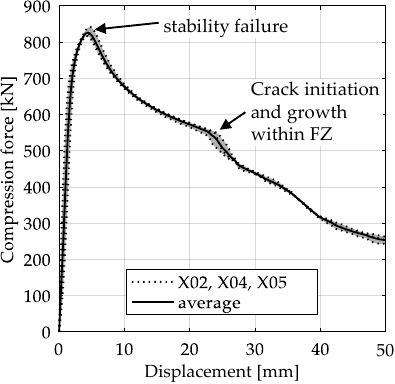
Figure 17. Averaged force–displacement curve with scatter band of axial compression tests with 10-mm plate thickness (data from [27]).